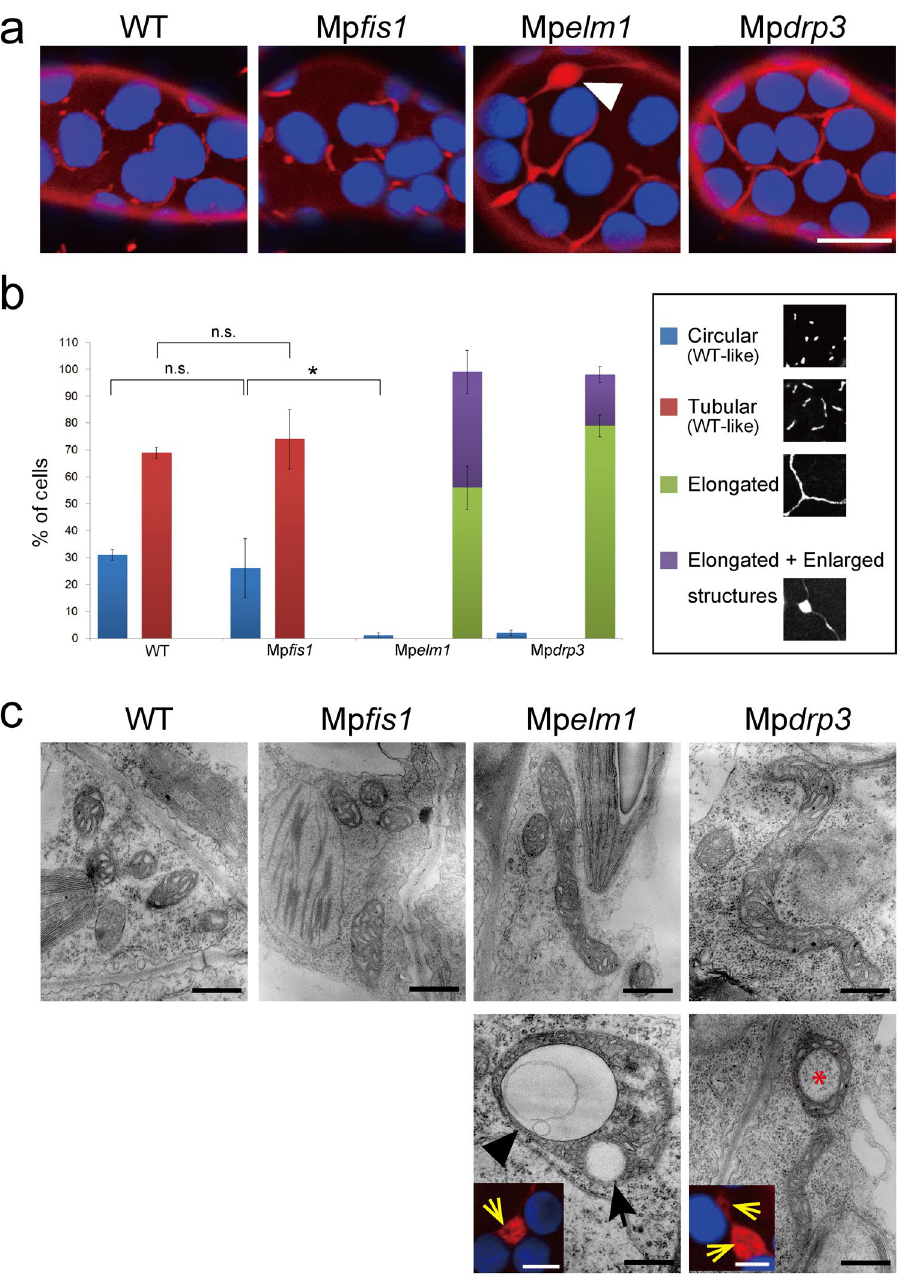
Figure 4. Mitochondrial phenotypes of the mutants. ( a ) CLSM image of the epidermal cell in wild-type and each mutants stained with MitoTracker. The arrowhead indicates an enlarged structure of mitochondria. Blue signals are chlorophyll autofluorescence. Bar = 10 µ m. ( b ) Scoring of mitochondrial morphologies. Each cell was scored into one of four morphological categories. Representative images of each categories are shown in right panels. Data are means ± s.e.m. from three independent experiments. * P < 0.05; n.s., not significant; one-way ANOVA with Tukey’s multiple-comparison test. ( c ) Transmission electron micrographs of mitochondria in wild-type and each mutants. Lower panels are magnified images of enlarged structures in Mp elm1 and Mp drp3 . The black arrow indicates a vacuolated structure, the black arrowhead indicates a vesicle-like structure and the asterisk indicates the cytosol surrounded by mitochondria (Bars = 500 nm). Fluorescent images of enlarged structures stained with MitoTracker are shown in insets. The yellow arrows indicate the mitochondrial region which has little MitoTracker signals (Bars = 5 µ